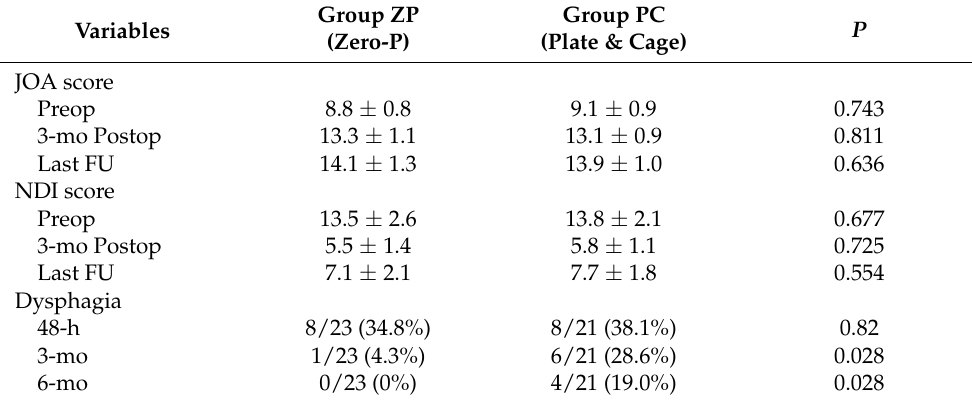
Table 3. Clinical outcomes of subjects.